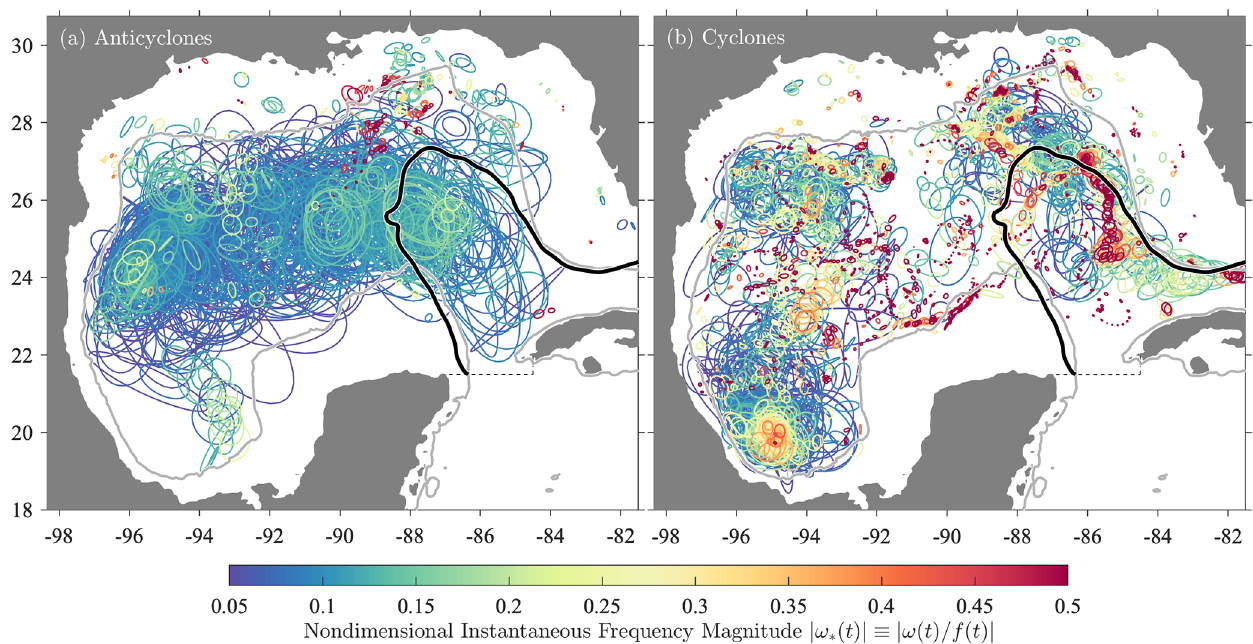
Figure 2. Ellipses from all statistically significant eddy signals in the dataset shown in Fig. 1 detected using the method described here, with anticyclonic events in (a) and cyclonic events in (b) . The time interval between successive ellipses is equal to the estimated period of the oscillation, 2 π/ | ω(t) | , where ω(t) is the instantaneous frequency defined subsequently in Eq. (34). The colored shading is the nondimensional instantaneous frequency magnitude | ω ∗ (t) | ≡ | ω(t)/f (cid:5) (t) | , in which ω(t) has been normalized by the Coriolis frequency at the latitude of the ellipse’s center, denoted f (cid:5) (t) . It will be shown that 2 | ω ∗ (t) | is an estimate of the local Rossby number of the oscillatory flow. Ellipses are plotted in reverse order of their | ω ∗ (t) | value, thus placing higher-frequency, more nonlinear features on top. The asymmetry between cyclonic and anticyclonic features is strikingly apparent. Other lines are as in Fig.